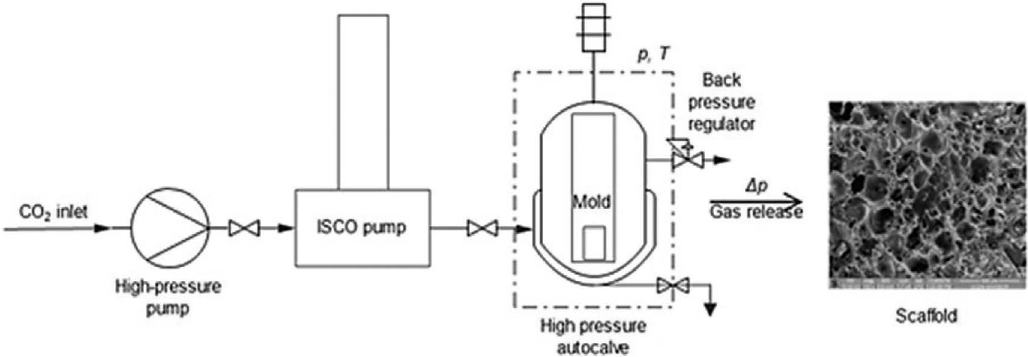
Figure 1. Diagram of the system used to generate biodegradable scaffolds with scCO 2